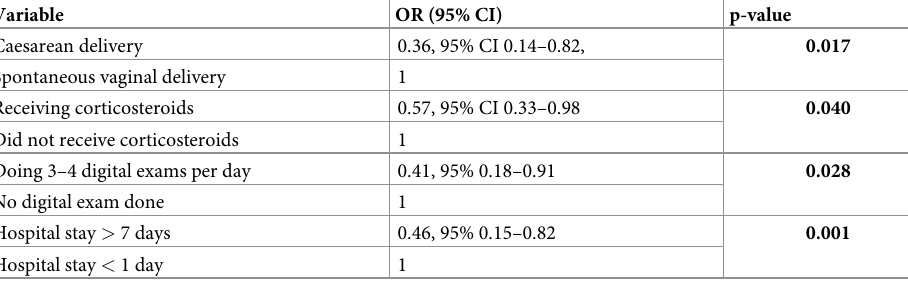
Table 4. Multivariate association between perinatal mortality and independent variables for mothers delivering between 24 to 28 weeks of gestation at Kawempe National Referral Hospital,